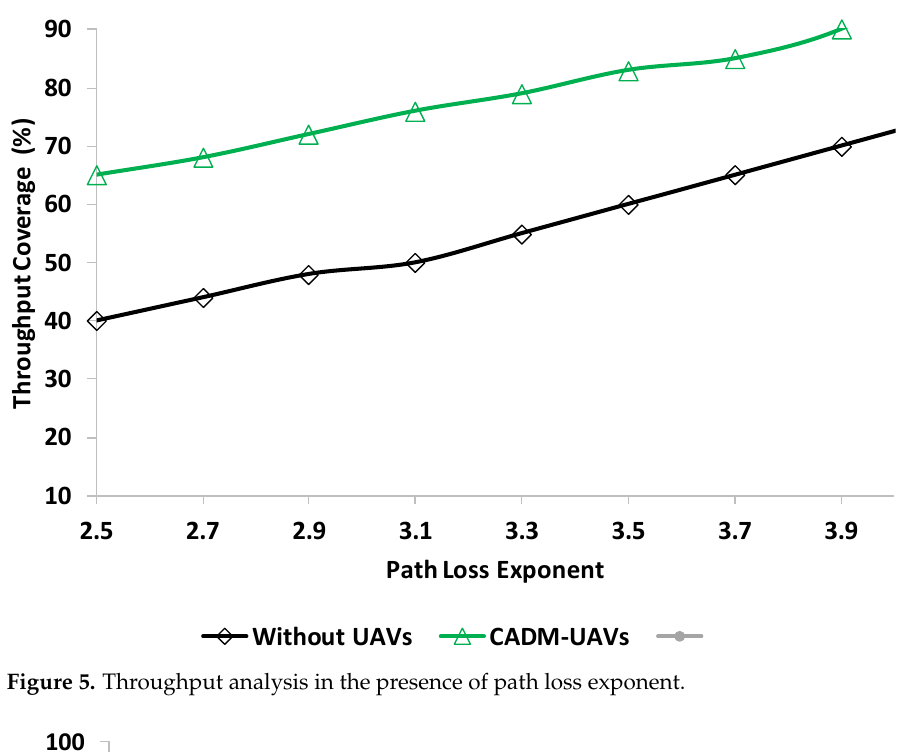
Figure 5. Throughput analysis in the presence of path loss exponent. In throughput analysis, the throughput coverage percentage is defined. The cover- age percentage of users is defined with a high SINR from the threshold, which is around 65%. As shown in Figure 5 the proposed model throughput coverage is better compared with non-UAV networks. The path loss exponent refers to the distance between the transmitter and the receiver and is measured in meters. Figure 6 shows the throughput analysis in the presence of users in a single macrocell.